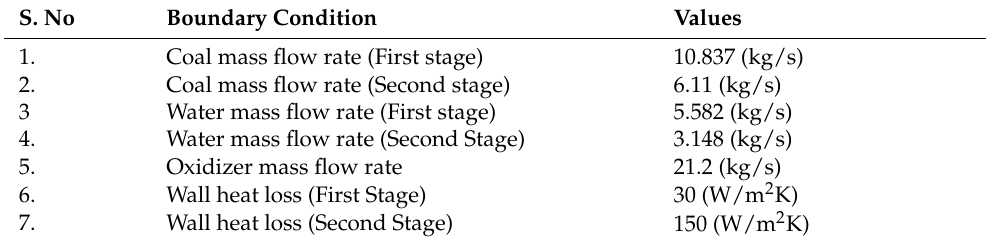
Table 4. Boundary